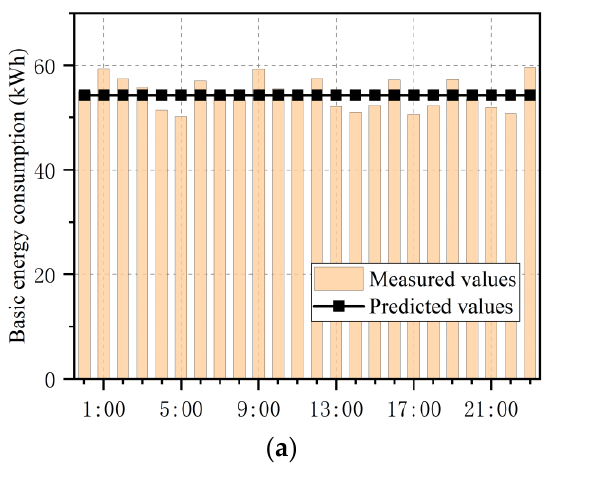
consumption of Case Building B.